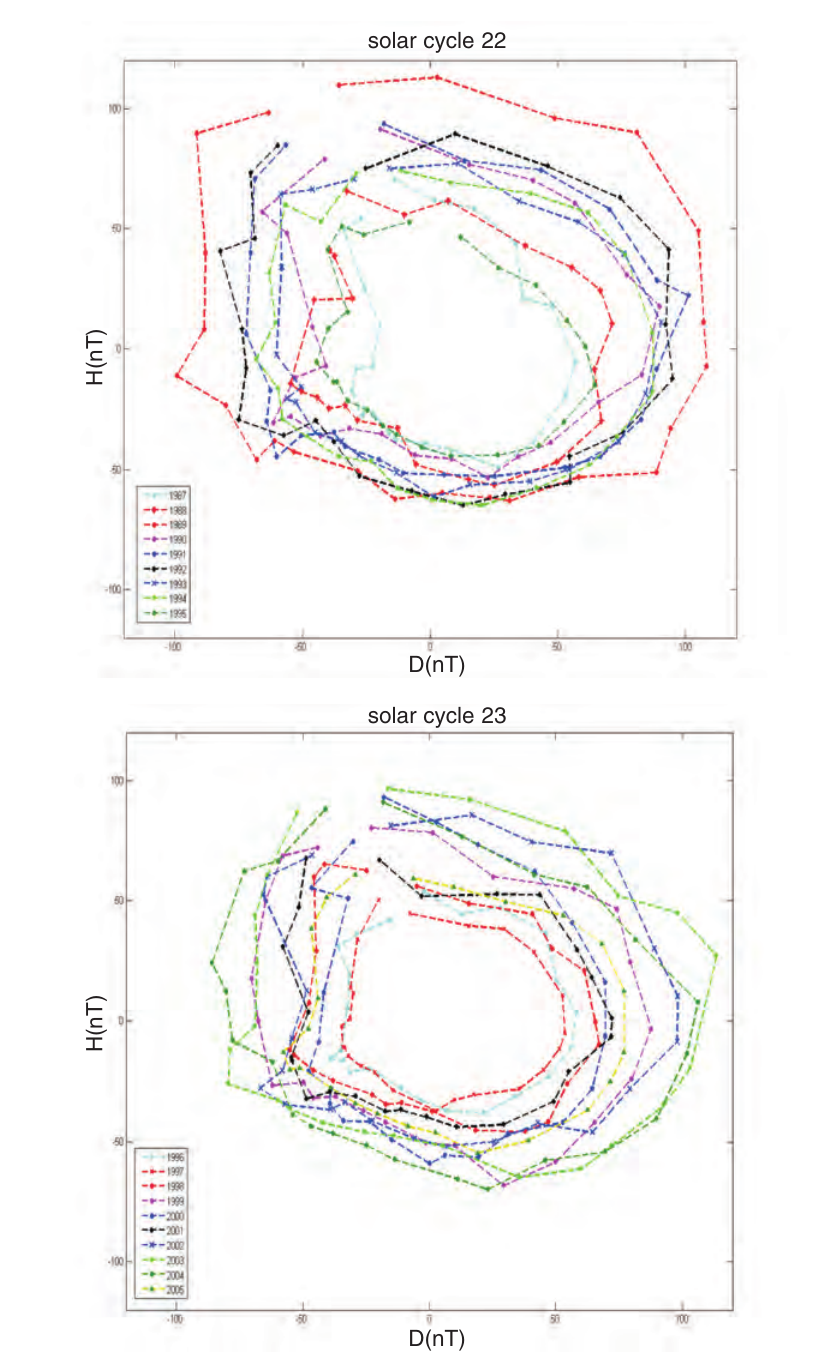
Fig. 6. Magnetic field hodograms for solar cycle 22 and solar cycle